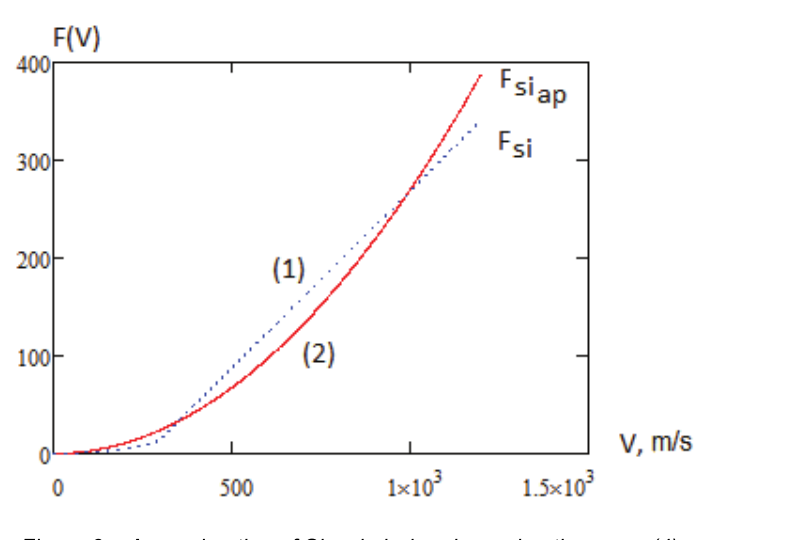
Figure 3 – Approximation of Siacci air drag law using the curve (4) Рис . 3 – Аппроксимация закона Сиаччи кривой